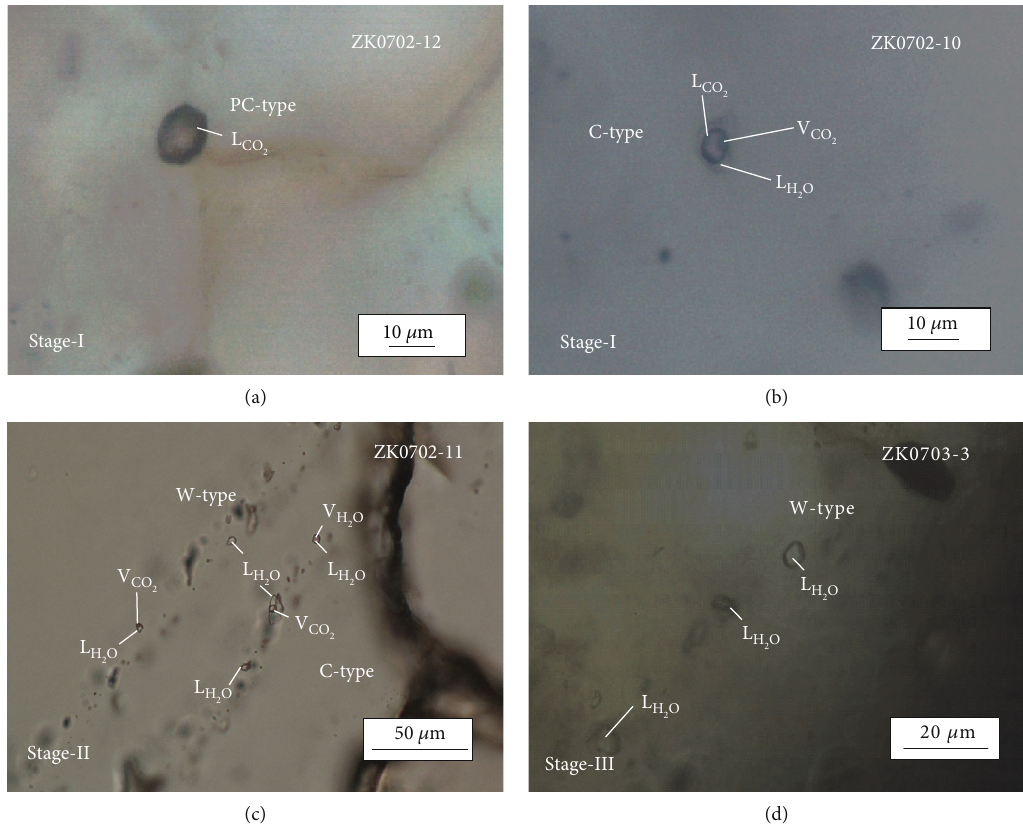
Figure 5: Photomicrographs of typical fl uid inclusions in the Yuka gold deposit. (a) Primary PC-type fl uid inclusion in stage-I quartz. (b) Primary C-type fl uid inclusion in stage-I quartz. (c) Primary C- and W-type fl uid inclusions in stage-II quartz. (d) W-type fl uid inclusions in stage-II quartz. Abbreviation: V